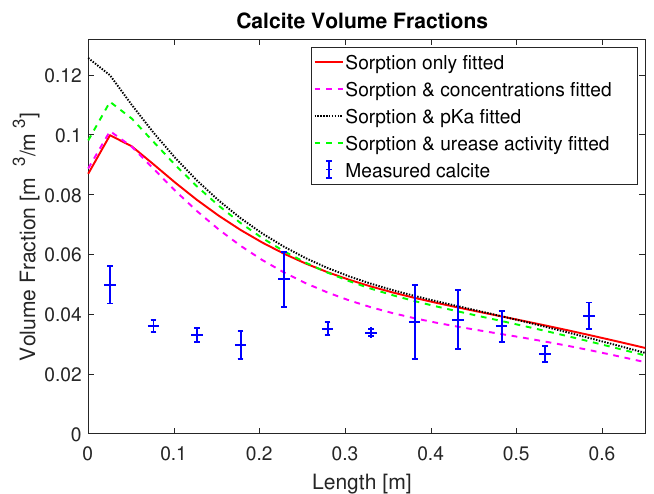
Figure 4. Predicted volume fractions of final calcite for the model calibration attempts compared to the experimental data for column experiment #1 (0.33 M mineralization medium concentration) for the four parameter sets fitted: The error bars represent the standard deviation calculated from triplicate measurements. Note that the calcite volume fraction was not used for